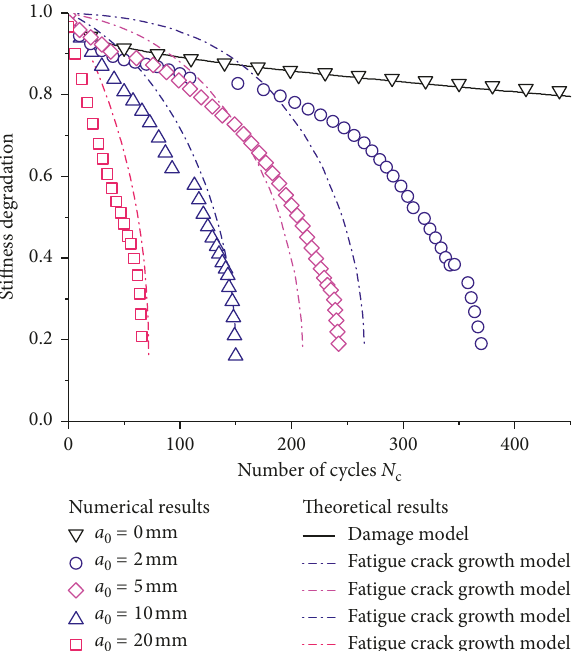
Figure 18: Stiffness degradation as a function of the number of cycles N c for different initial crack